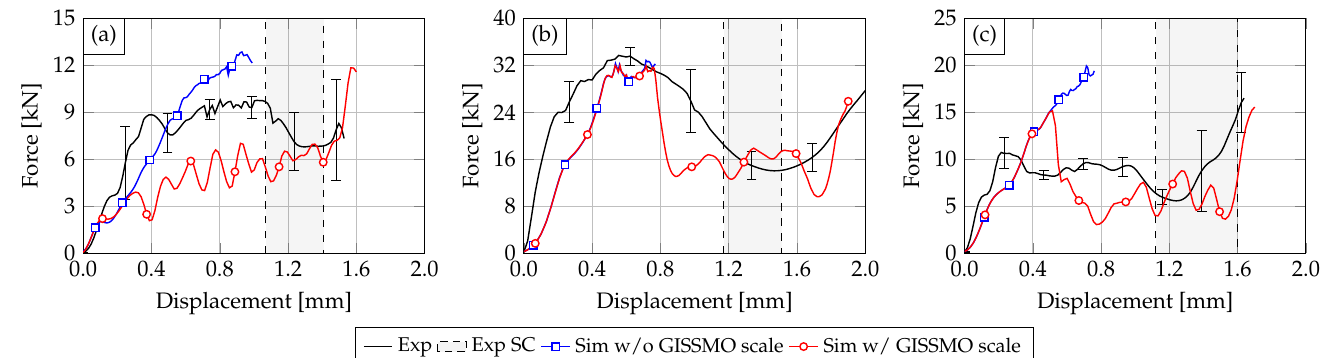
Figure 13. Comparison of the experimental (solid black curve) and numerical results without strain rate scaling GISSMO parameters (solid blue curve) and with strain rate scaling (solid red curve) for the PA6GF30 busbars with impactor V1 ( a ), V4 ( b ) and V5 ( c ). The experimental electrical SR ranges are also displayed.